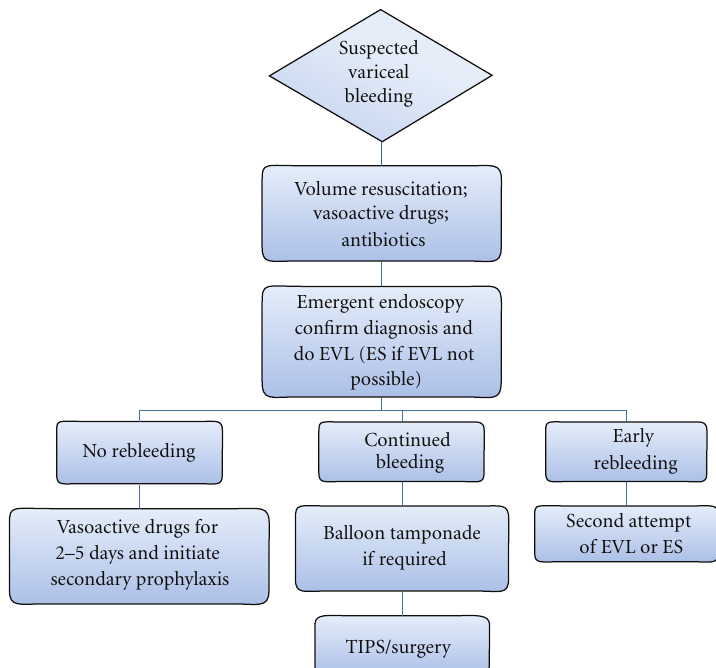
Figure 3: Algorithm for management of acute variceal bleeding. EVL indicates endoscopic variceal ligation; ES: endoscopic sclerotherapy; TIPS: transjugular intrahepatic portosystemic